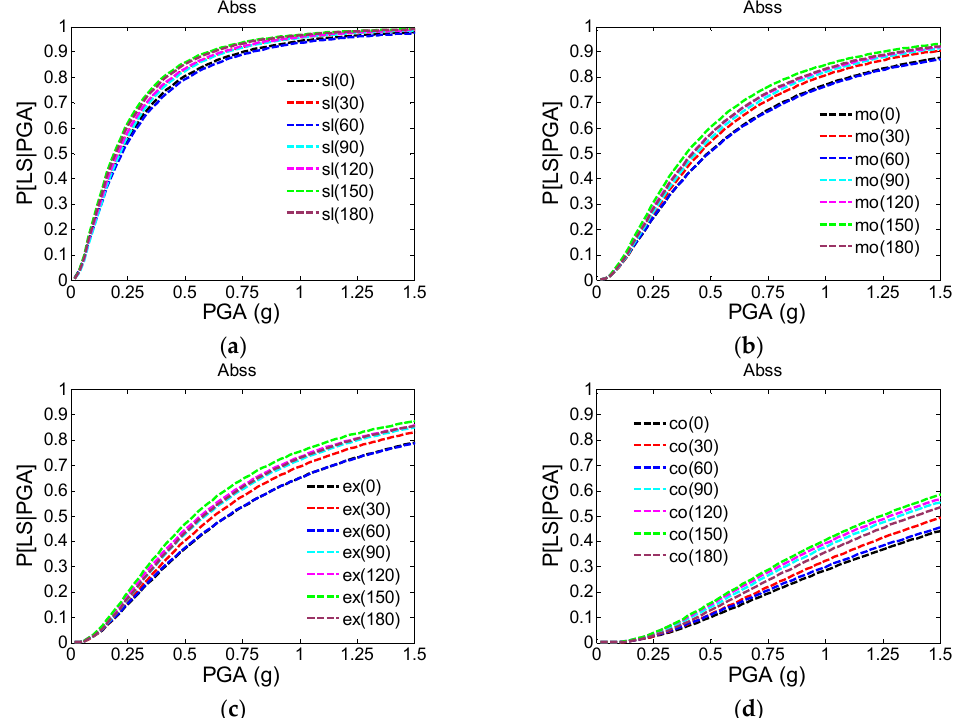
Figure 10. Seismic fragility curves of Abss subjected to different excitation angles in the ( a ) slight; ( b ) moderate; ( c ) extensive; and ( d ) complete limit states.